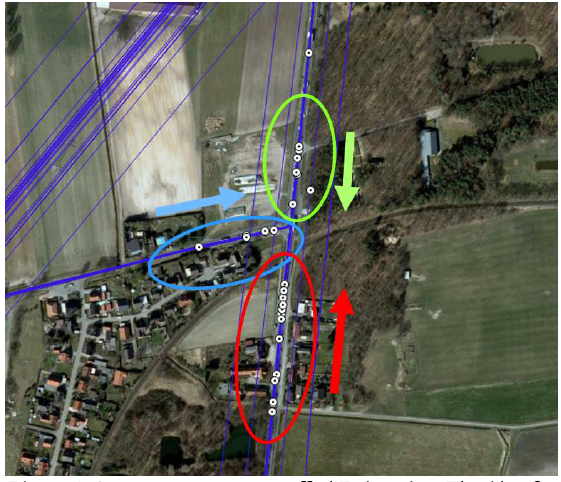
Figure 4. Stop events at a controlled T-junction. The idea for discovering intersections is based on the assumption that the centers of groups of nearby clusters of stop events from vehicles that moves in conflicting headings can reveal the position of the intersection Figure 5. Clusters of stop events detected with methods 1 and 2